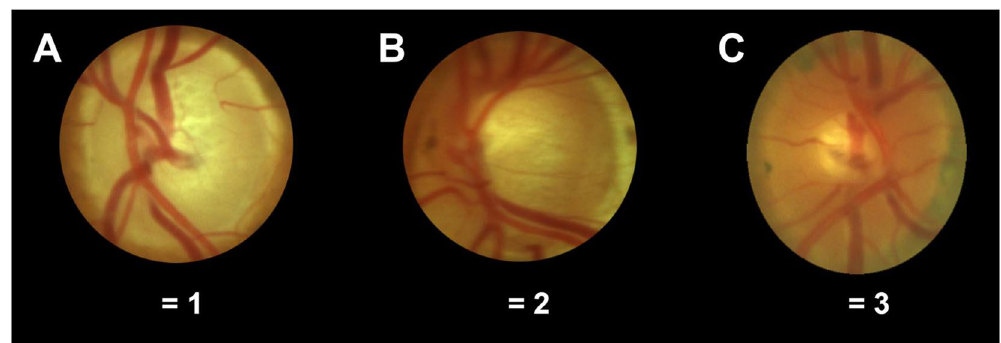
Figure 4. Optic disc pallor grading. Optic disc pallor was graded on a 3-step-scale with these exemplary images for 1 = pale ( A ), 2 = borderline ( B ) and 3 = vital ( C